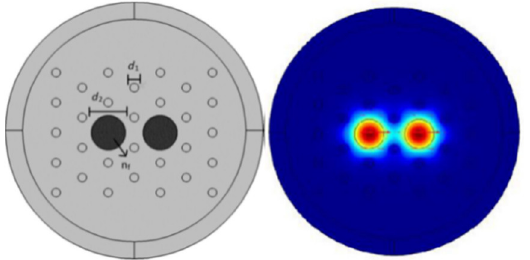
Figure 34. Schematic diagram of the Mach-Zehnder interferometer structure based on tapered PCF coated with ferrofluid for the magnetic field intensity measurement (Figure courtesy from the reference [101]).